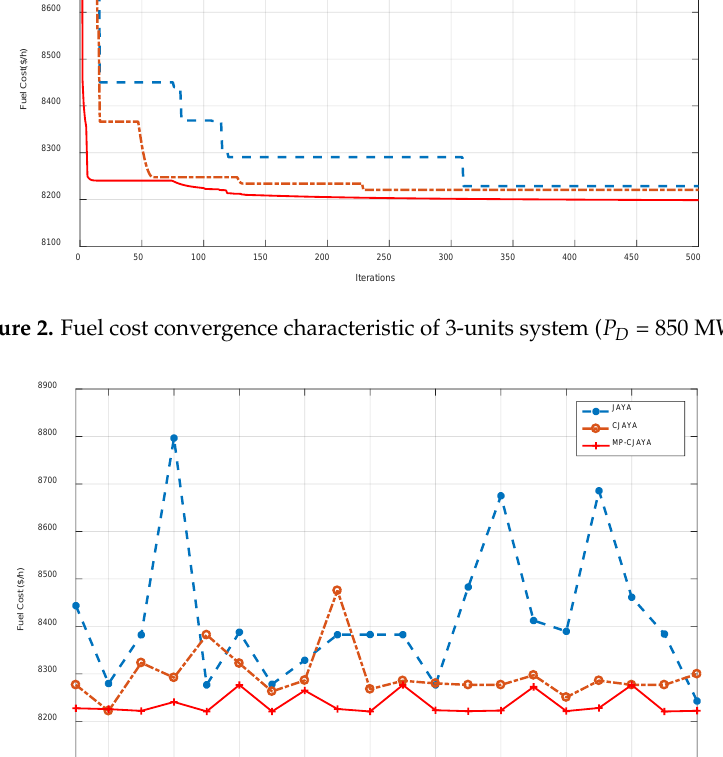
Figure 3. Fuel cost for 20 independent runs of 3-units system (